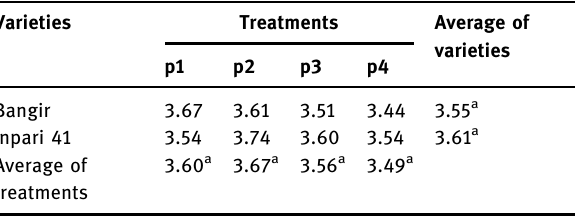
Table 5: One hundred - grain weight ( g ) of two rice varieties fertilized with di ff erent types of organic manure Varieties Treatments Average of